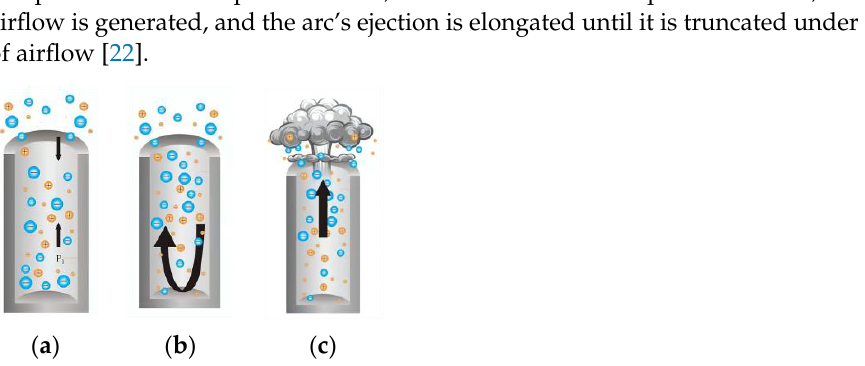
Figure 1. Schematic diagram of the gas arc-extinguishing process. ( a ) Pre-breakdown ( b ) Arc maintenance ( c ) Arc extinguished.